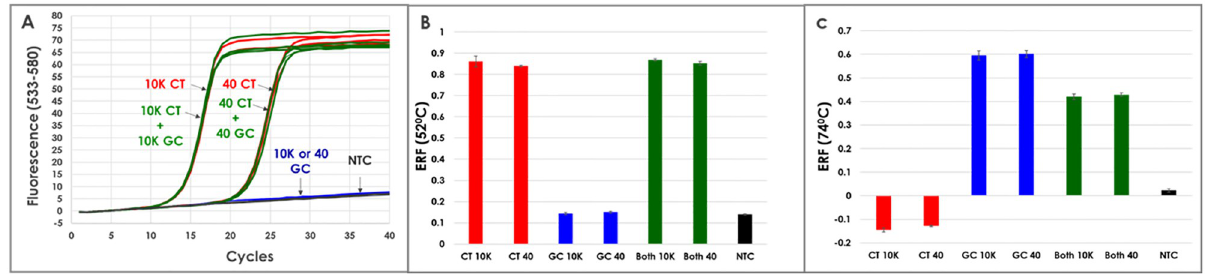
Fig 2. Results of model assay detecting CT/GC in a single channel. The protocol combined one linear probe reporting on CT together with one PlexProbe reporting on GC where both probes were labelled with the same fluorophore (JOE). Triplicate reactions contained either 10,000 (10K) or 40 copies of CT template (red), 10,000 or 40 copies of GC template (blue), 10,000 or 40 copies each of both CT and GC (green) or no template (NTC) (black). (A) PCR amplification curves acquired at 52˚C demonstrate real-time quantitative results for CT in the presence or absence of GC. (B) Endpoint relative fluorescence (ERF) obtained post-PCR at 52˚C, calculated according to Formula A, allows qualitative detection of CT in samples in the presence or absence of GC. (C) ERF obtained post-PCR at 74˚C, calculated according to Formula B, allows qualitative detection of GC in samples in the presence or absence of CT. Error bars represent the standard